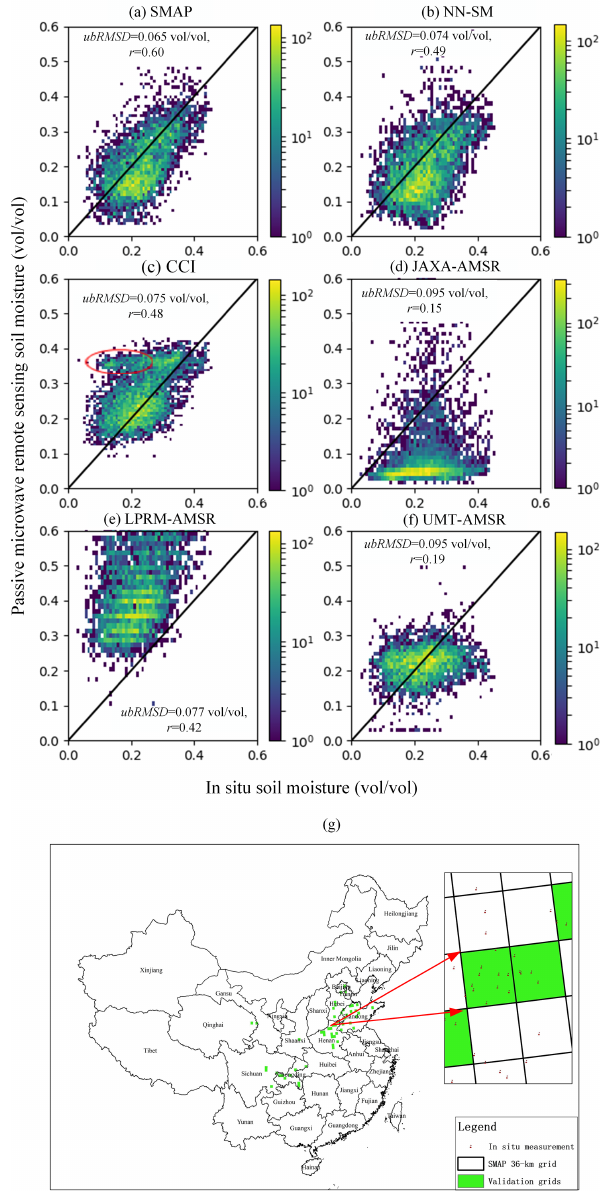
Figure A1. (a–f) Comparison of different PM SSM products (as reported in Table 1) against the in situ SSM measurements in China. (g) Locations of the 36km EASE-Grid projection-based pixels used for this comparison